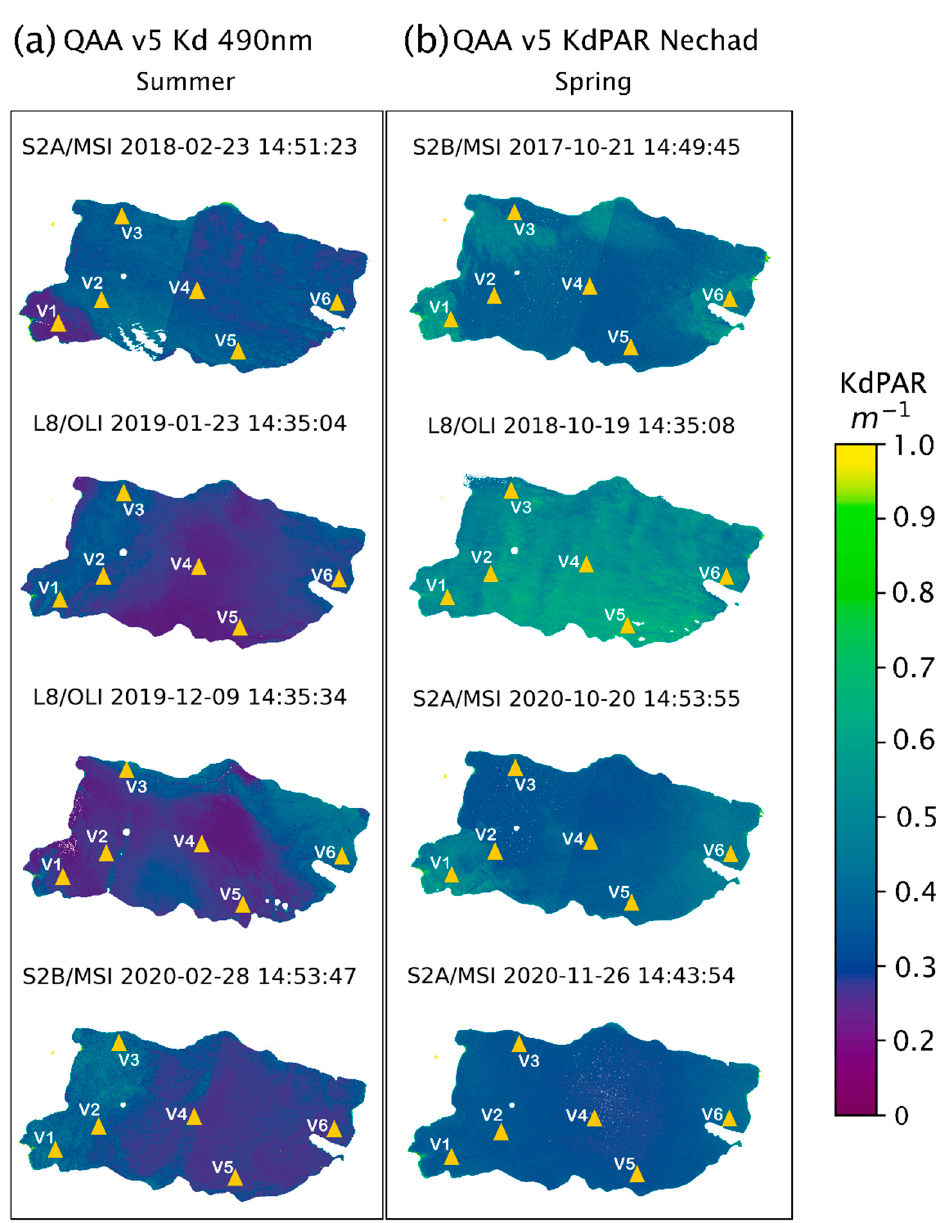
Figure 5. Seasonal spatial pattern of KdPAR estimation using ( a ) QAA v5 Kd490 nm and ( b ) QAA v5 KdPAR Nechad during summer and spring in Lake